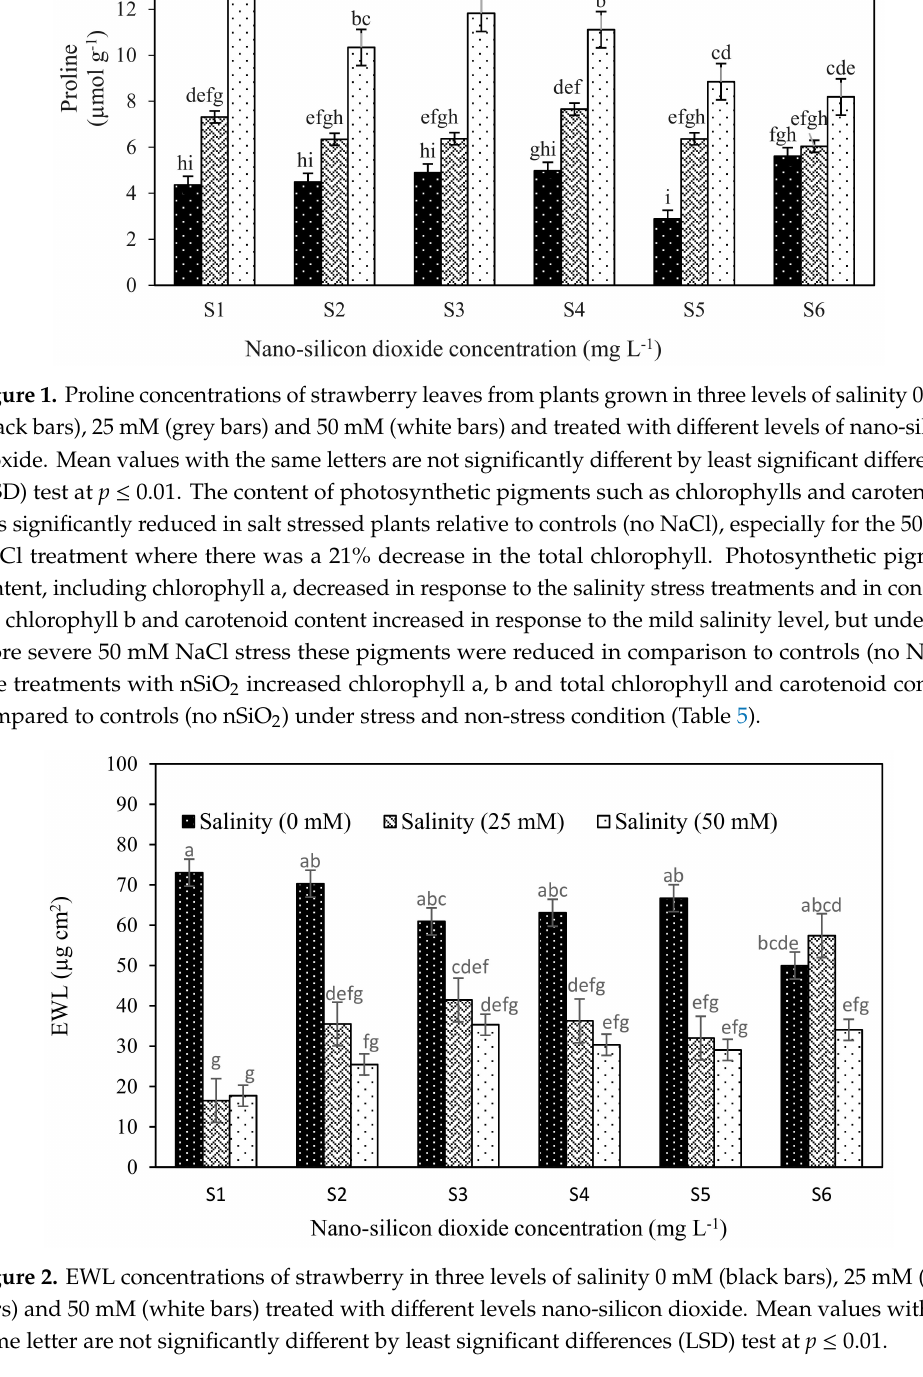
− 1 100 mg L nSiO 2 before BBCH: 61 and 50 mg L